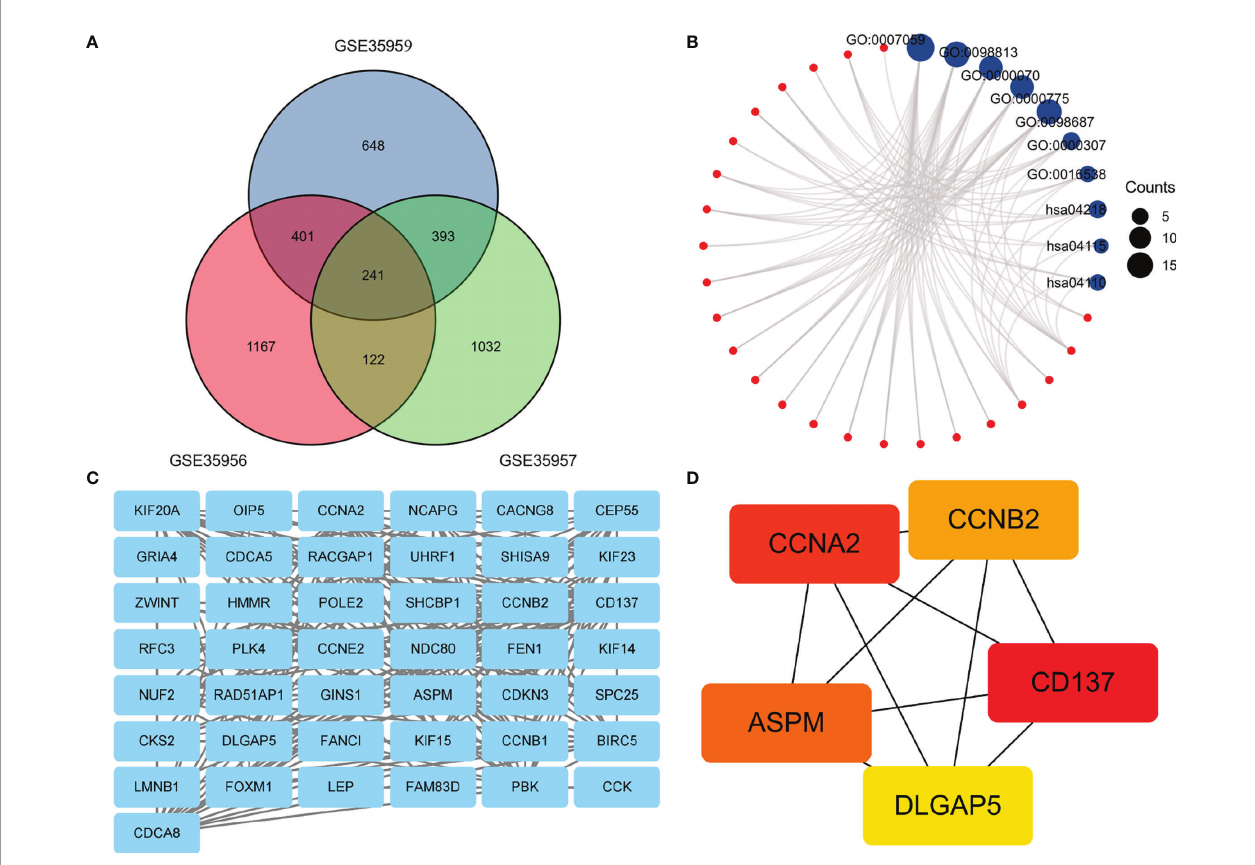
FIGURE 2 | (A) An extended range of DEGs were selected from GSE35956, GSE35957 and GSE35959. |log FC| > 1, P value < 0.05. (B) . GO and KEGG enrichment analysis of DEGs. (C) PPI network construction and analysis of hub genes. (D) Hub genes were selected according to the top 5 nodes ranked by degree using cyto-Hubba. DEGs, differentially expressed genes; KEGG, Kyoto Encyclopedia of Genes and Genomes; PPI, protein – protein